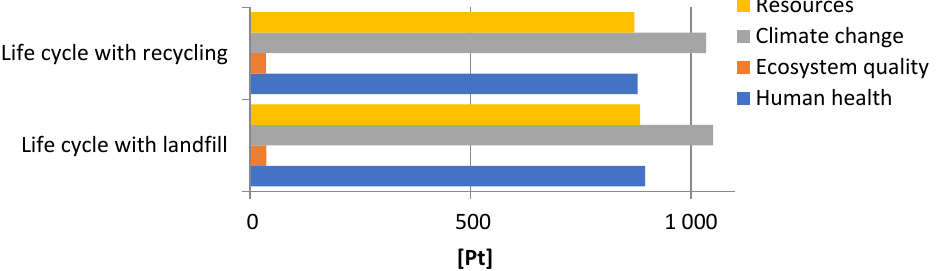
Figure 16. The results of grouping and weighing the environmental consequences occurring in the life cycle of the research object by the form of post-use development and areas of influence.